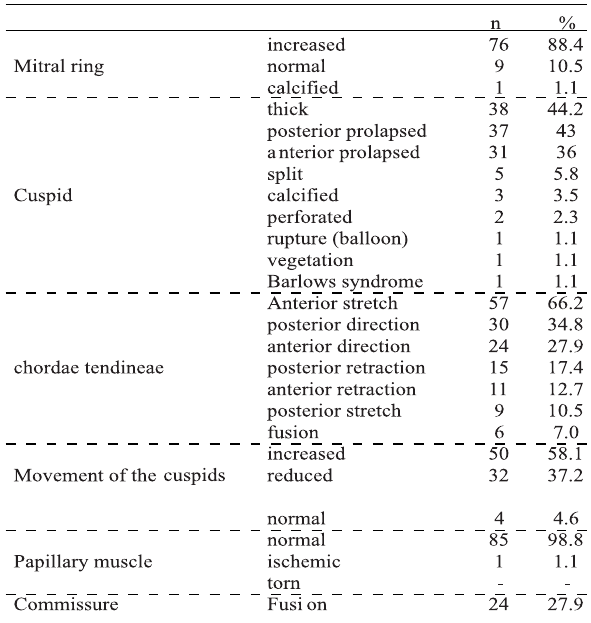
Table 3. Intra-operative pathologic findings.